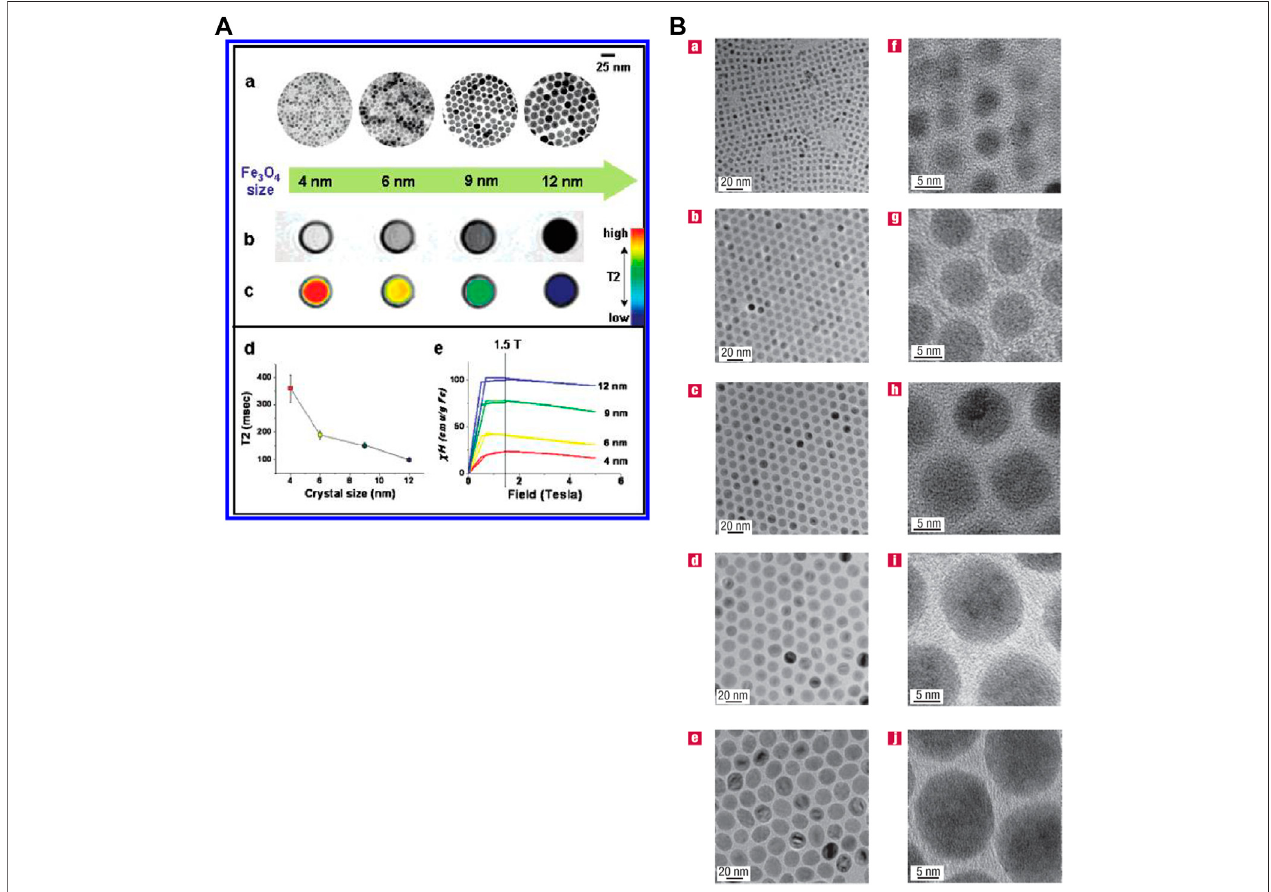
FIGURE 2 | (A) Water-soluble Fe 3 O 4 nanocrystals ’ size effects on magnetism and MR signals. (B) Transmission electron microscope images of different oleic-